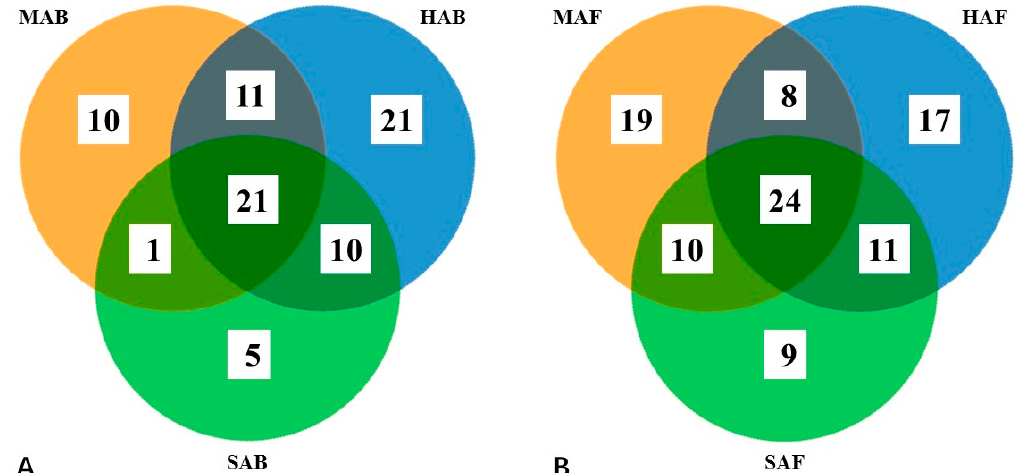
Figure 1. The unique and overlapping bacterial ( A ) and fungal ( B ) OTUs assembled from the three treatment conditions. HAB and HAF indicate healthy aphids, MAB and MAF mycotized aphids, and SAB and SAF starved aphids.